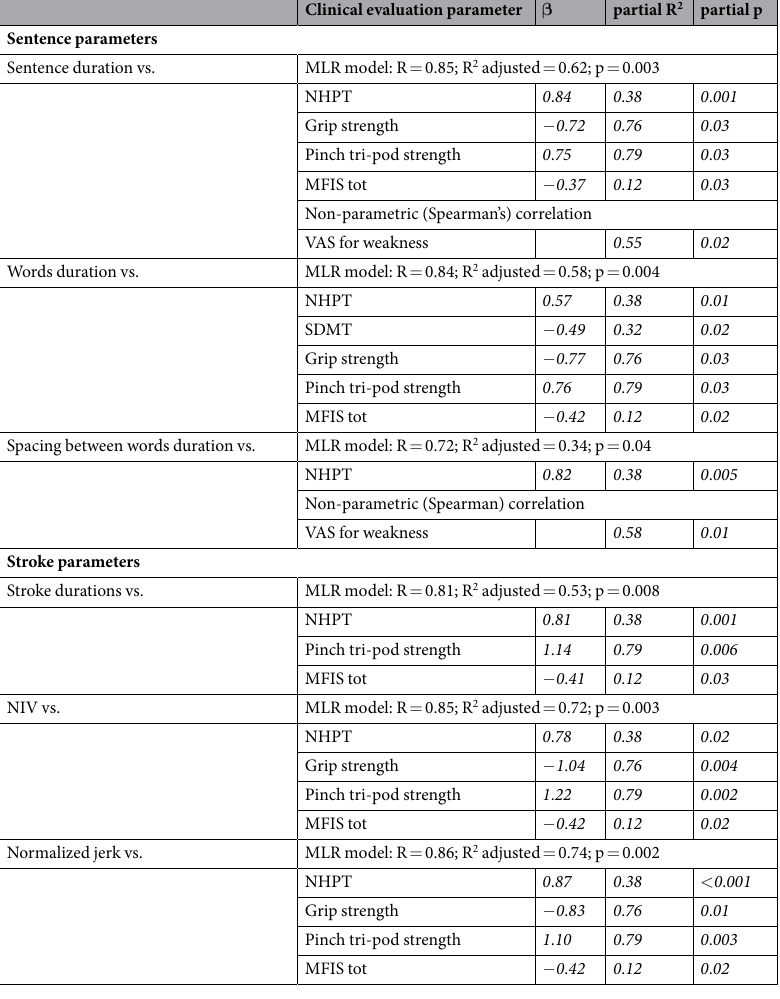
Table 2. Results from the correlation analysis between kinematic parameters and clinical scales evaluations (only significant correlations are